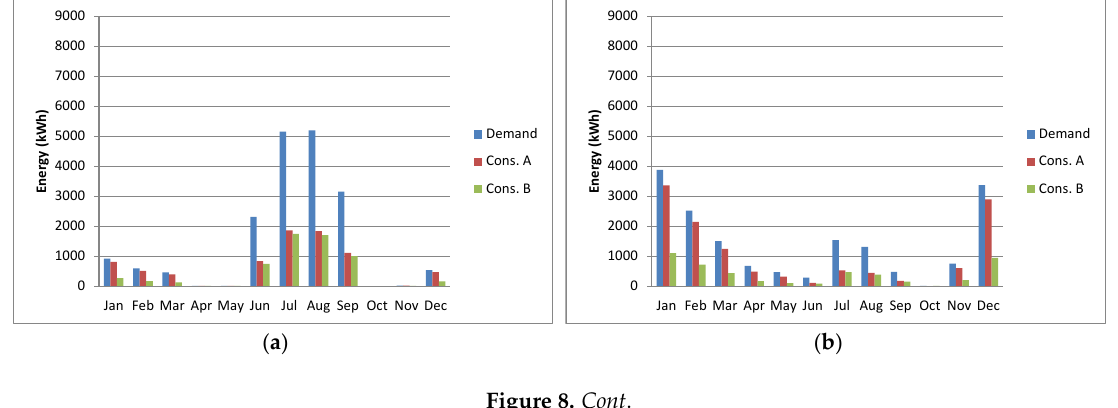
Table 4. System B nominal features.